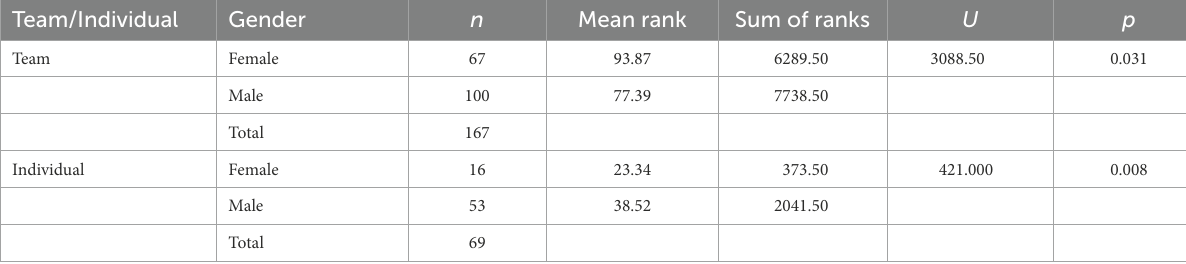
TABLE 4 Mann–Whitney U test results by gender in team and individual sports.